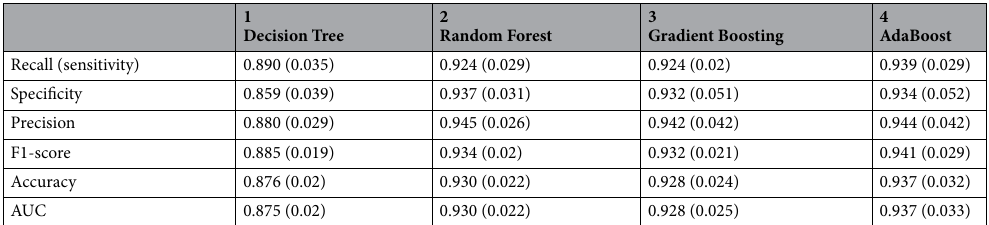
Table 2. Classification models performance metrics. This table shows the predictive performance across four classification models (1) Decision tree, (2) Random Forest, (3) Gradient Boosting, (4) AdaBoost. For each metric we present the mean value and standard deviation based on ten-fold cross-validation.